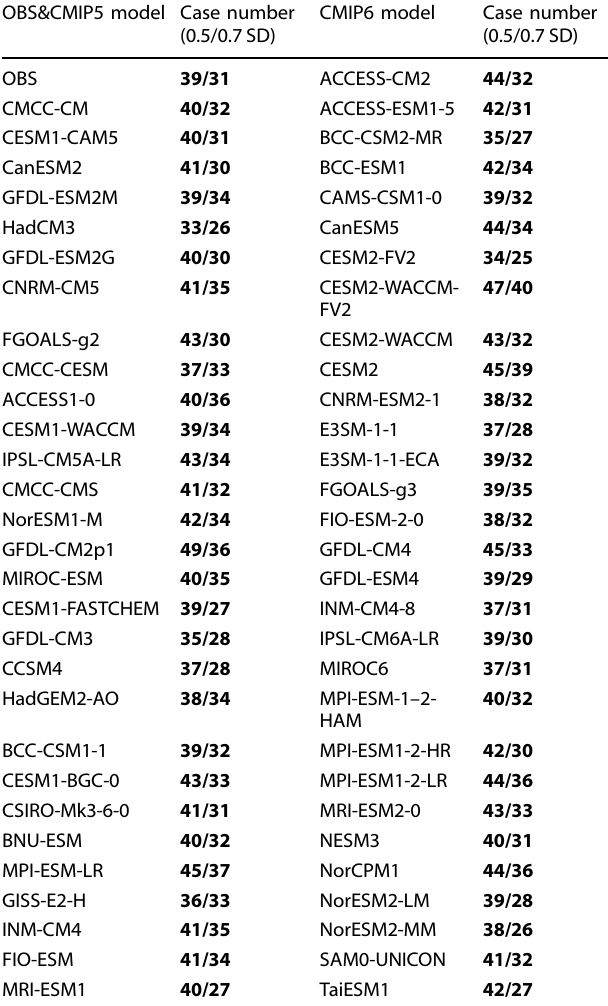
Table 1. CMIP5 and CMIP6 models used in this